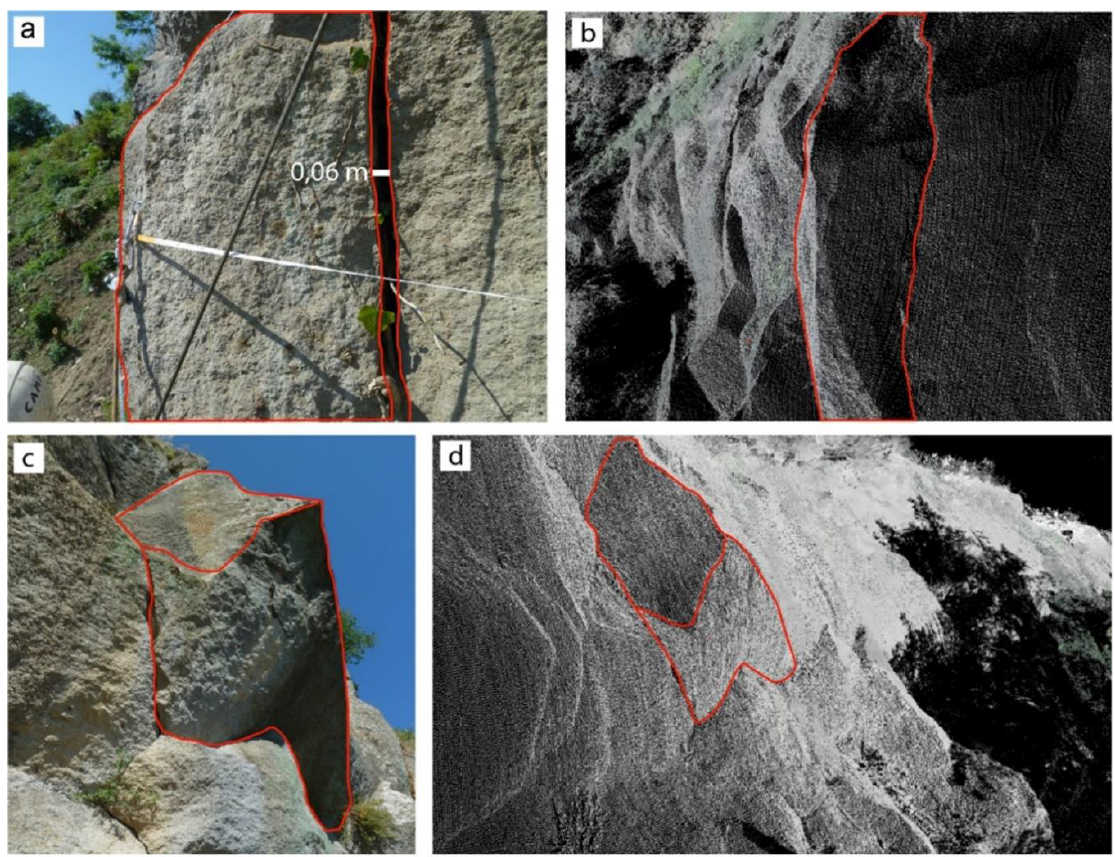
Figure 6. ( a , c ) Prismatic blocks prone to the detachment observed during the in situ geomechanical survey; and ( b , d ) the same blocks identified on the point cloud.